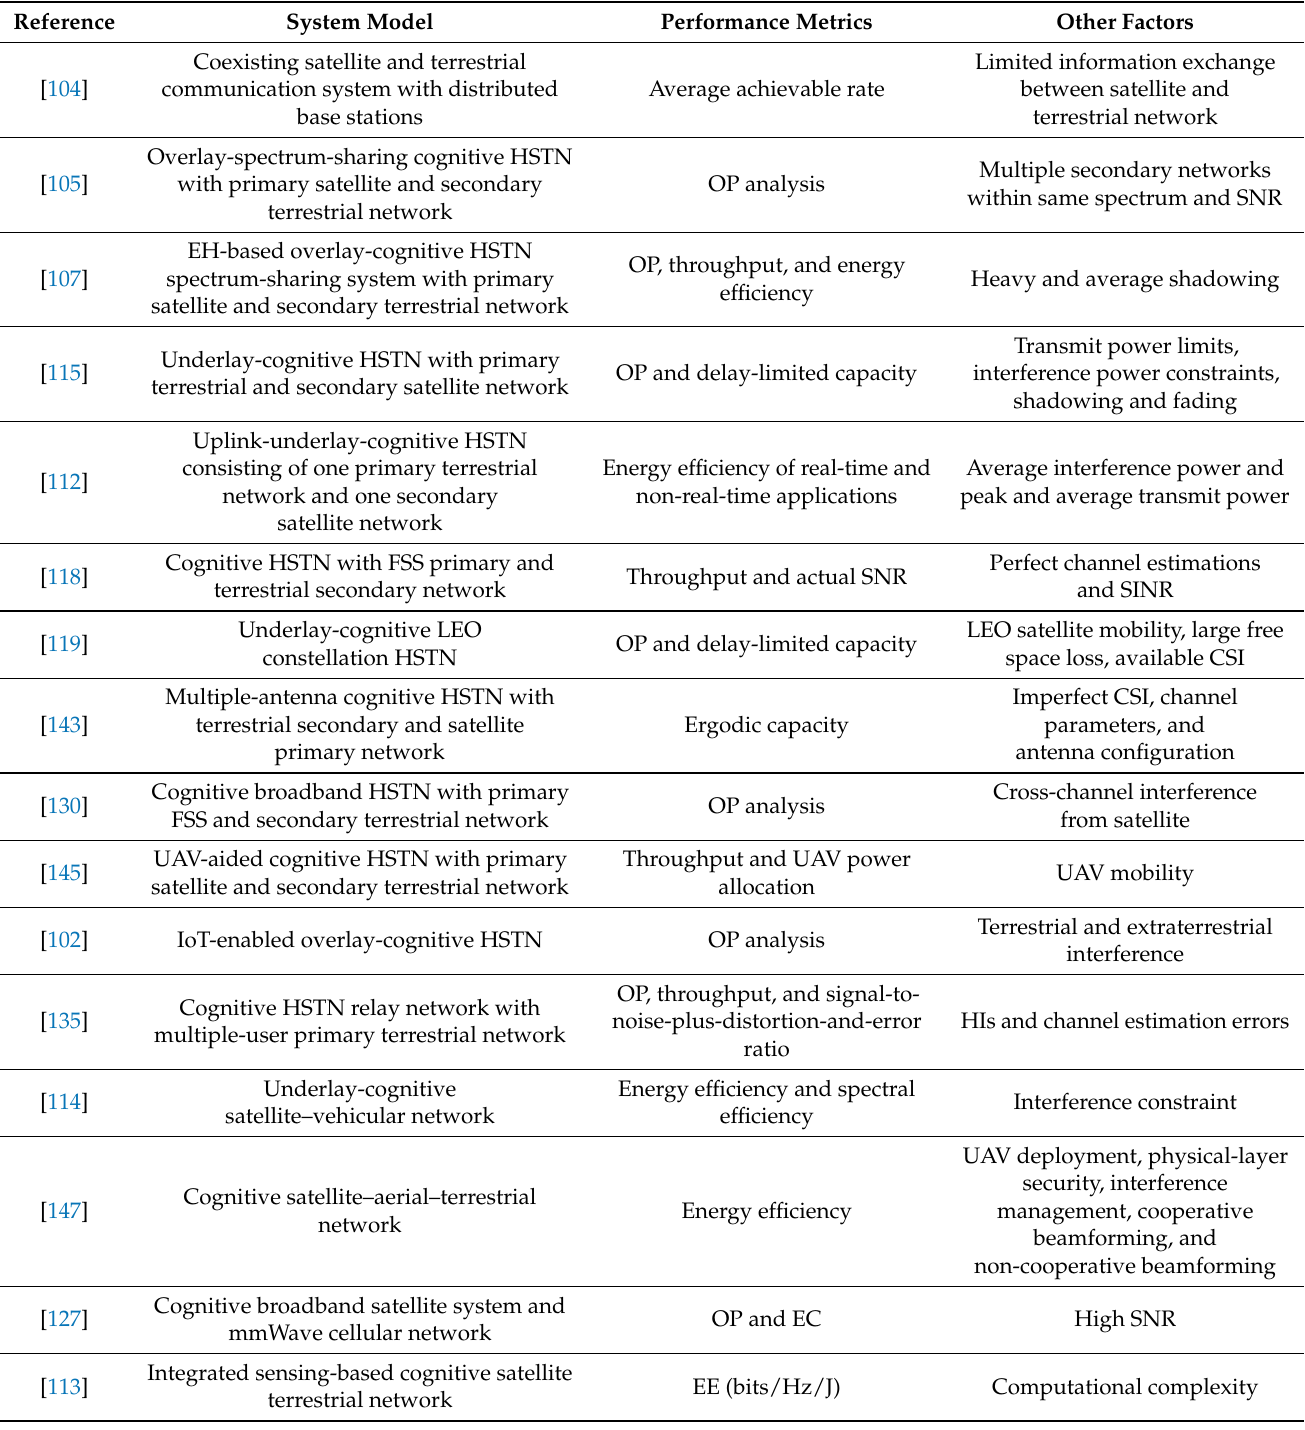
Table 5. List of major contributions to cognitive HSTN